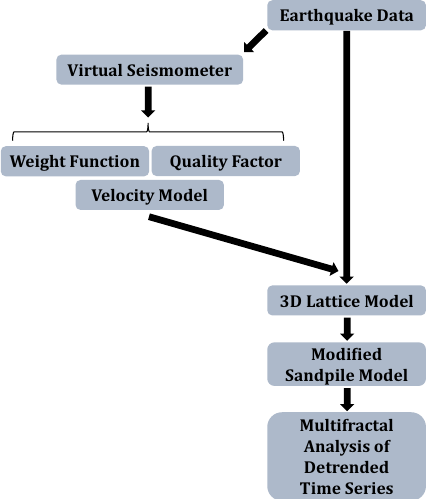
Figure 1. The work flow of the paper. We start from the data set obtained by the velocity model, the Q -factor, and the weighted matrix between cells (calculated by signals-cross-correlation procedure). These quantities are employed as the input parameters of a modified sandpile model. At the end, the time series of the sandpile model is studied using the multifractal analysis of detrended time series.